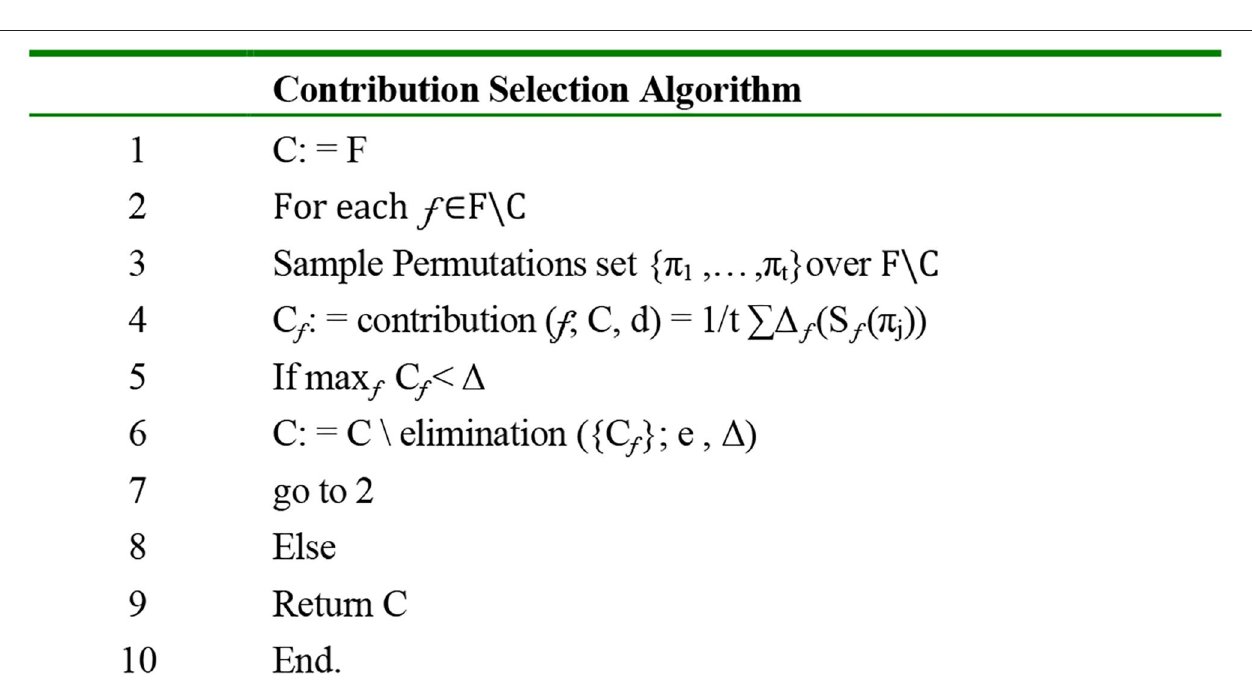
FIGURE 6 | CSA backward elimination algorithm